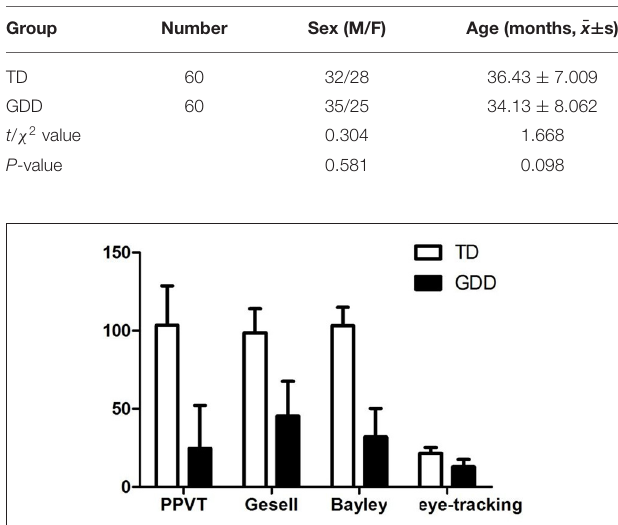
FIGURE 2 | PPVT, Gesell, Bayley, and eye-tracking technology in TD and GDD.